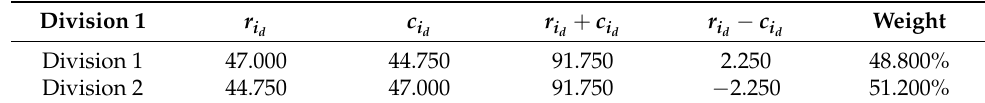
+ c − c i d , r i d i d and weights versus each aspect. d